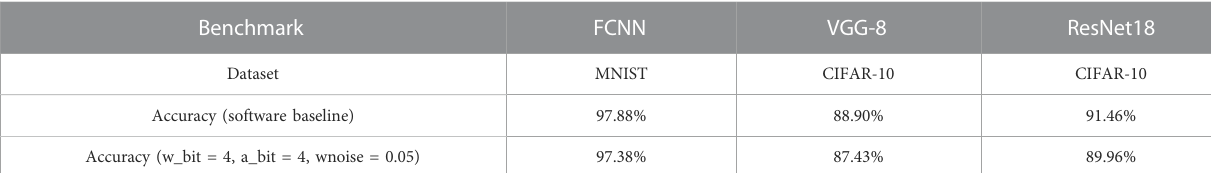
TABLE 2 The accuracy of different neural networks.